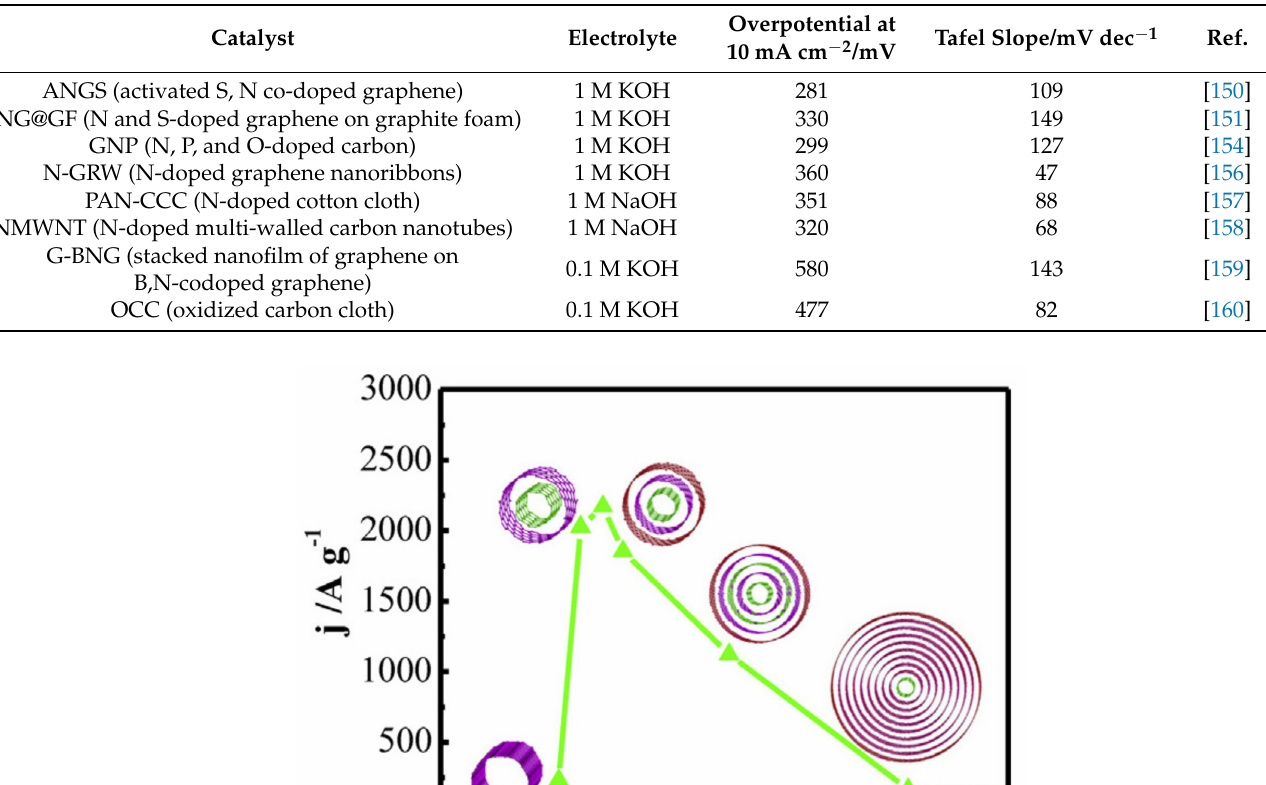
Table 2. Selection-comparison of metal-free carbon electrocatalysts.